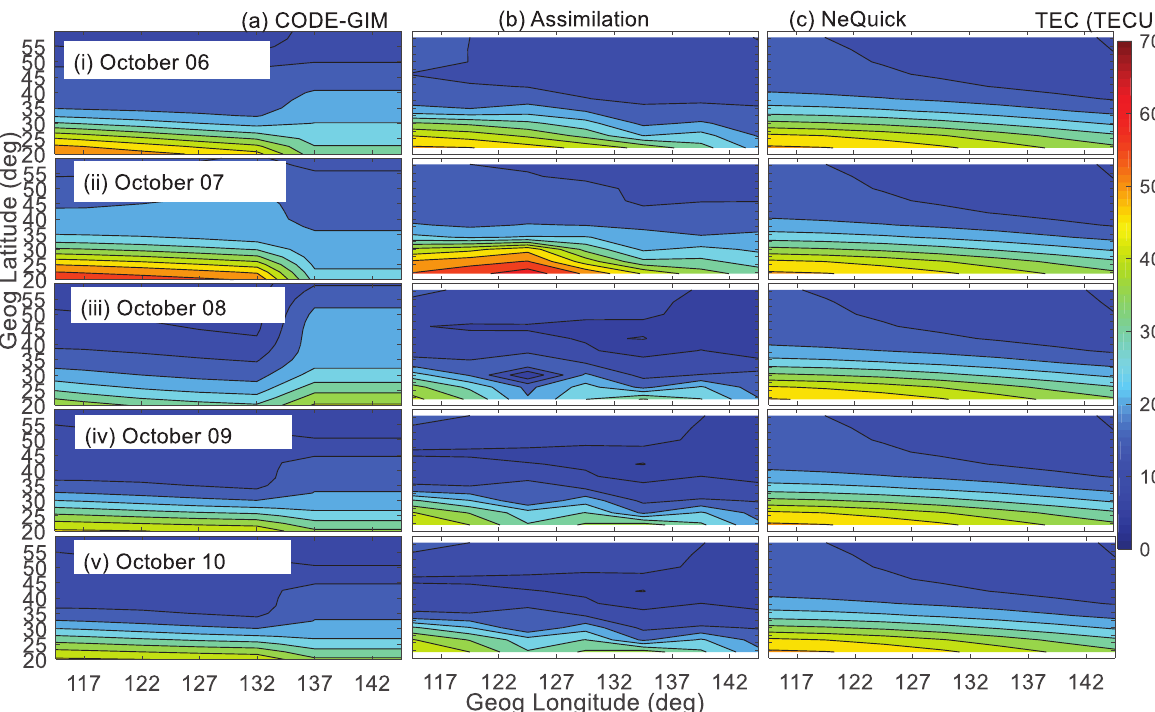
Figure 11. Panels in columns (a) – (c) present TEC obtained from CODE GIMs, assimilation, and NeQuick model, respectively. Panels in rows (i) – (v) present the TEC data at 05:00 UT during October 6 – 10, 2015,